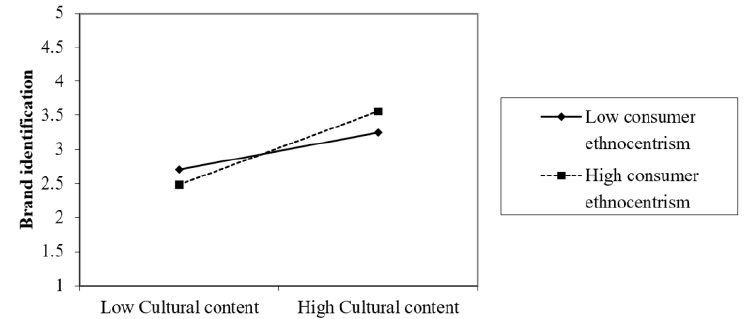
Figure 5 : The moderating effect of consumer ethnocentrism on the relation between cultural content and brand identification